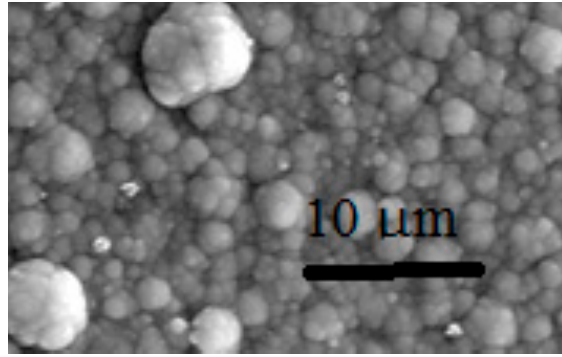
Figure 4. SEM micrographs (magnification 5000×) of PP3.